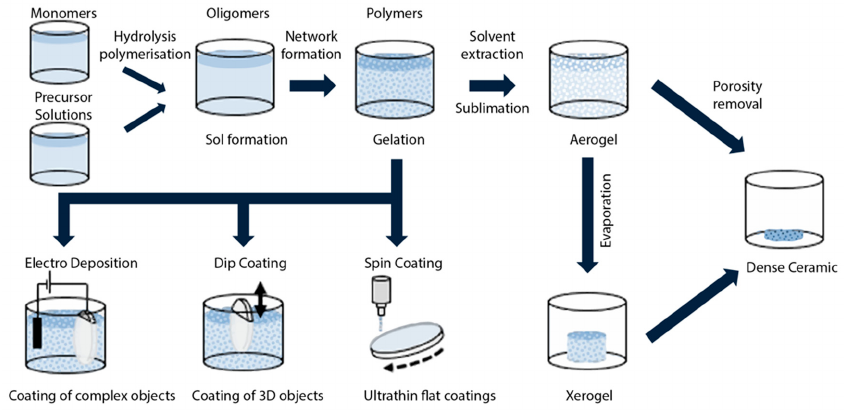
Figure 1. Simplified illustration of the main steps in the fabrication of bulk or thin-film sol–gel glasses Figure 1. Simpli fi ed illustration of the main steps in the fabrication of bulk or thin- fi lm sol–gel glasses or ceramics. A speci fi c additional heat treatment may lead to the creation of glass-ceramics. or ceramics. A specific additional heat treatment may lead to the creation of glass-ceramics. Aerogel and xerogel are two forms of dried gels that can retain their porous texture after the drying process; aerogels are less dense and have a larger surface area and porosity (the porosity, namely the non-solid volume, must be greater than 50%). Either one is obtained from a gel depending on the drying rate. Aerogels fi nd large application in thermal insulation, adsorption, catalysis, drug delivery systems, and aerospace. Reproduced with modi fi cations from [16] under a Creative Com- mons license. Going back to the general area of sol–gel physics and chemistry, the 1980s saw the publication of only 172 papers, but in the following decade (1990–2000) the number of publications rose to 2950 and today the cumulative number is greater than 19,000 [17]. Sol–gel synthesis has proven to be particularly useful in the case of photonic glasses, where several issues must be faced, in particular, concerning the transparency and the composition, the la tt er being governed by the phase diagram. Sol–gel technology allows us to partially overcome such a constraint and also to improve the rare-earth solubility. The critical problem of luminescence quenching due to the physical clustering of rare- earth ions can be strongly mitigated by the appropriate composition and densi fi cation protocols, when the sol–gel route is employed [18]. Moreover, sol–gel technology allows us to develop photonic glasses with peculiar compositions and properties, in di ff erent forms (bulks, nanoparticles or thin fi lms) and with signi fi cant characteristics for di ff erent photonic applications. Some 340 papers have been published so far in this area [19], start- ing with the pioneer paper by Dunn and Zink, in 1991, who concluded that organic-doped sol–gel materials were emerging as an important means of producing photonic materials [20]. It is interesting to note that an earlier paper, published by Ramaswamy et al., in 1988 [21], reported the higher optical transmission (measured a tt enuation 0.21 ± 0.02 dB/cm) and lower dispersion of a silica sol–gel bulk glass compared to commercial silica; two routes were suggested for fabricating optical waveguides in such bulk glass; that is, ion di ff usion (they a tt empted to di ff use barium, but the results were not satisfactory) or local heating to increase the density and index of the glass. Later, a good review of early works on sol–gel photonic glasses was presented in the papers’ selection edited by Naja fi , in 1998 [22], whereas an overview of more current research is provided in the already mentioned book edited by Almeida et al. [15]. The present paper provides a short survey of some aspects crucial in sol–gel photon- ics that we have faced in our experimental activity and that could have some utility for both expert and early-stage researchers who may be fascinated by the sol–gel route in optics. The general focus is on the sol–gel synthesis and the characterization of rare-earth-